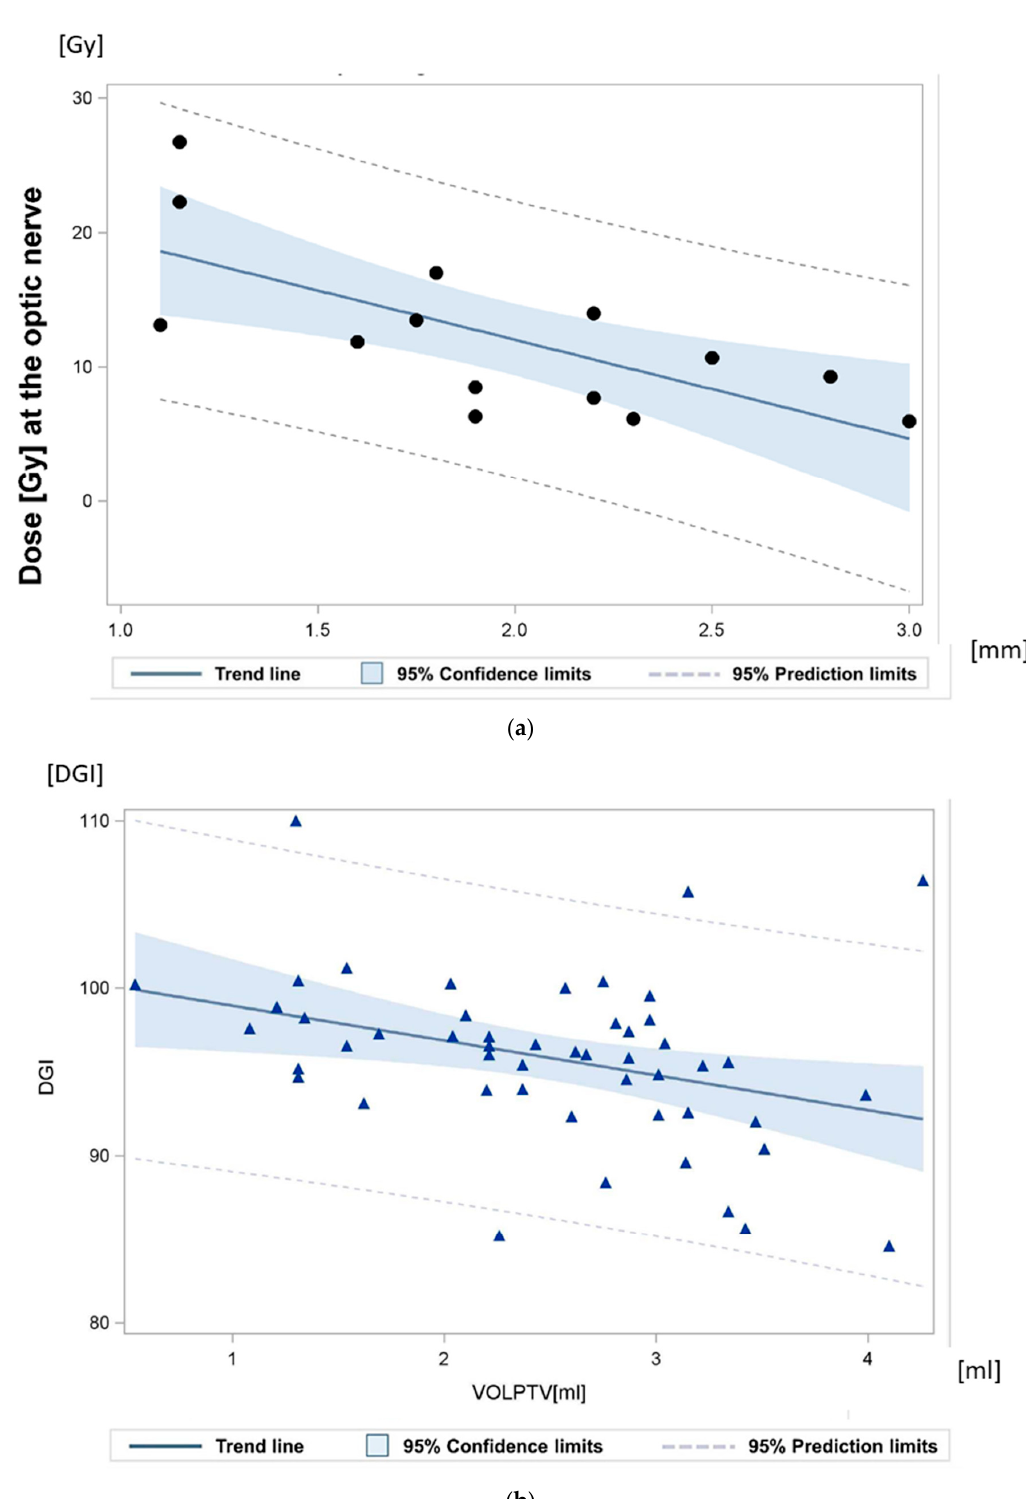
Figure 4. ( a ) Relationship between the maximum dose at the optic nerve, and the minimum distance between the gross tumor and the optic disc. The achieved dose gradient was 7.3 Gy/mm +/ − 2.1 Gy/mm. “ • ” Each sign representing the radiation plan of one patient. ( b ) Dose-gradient index (DGI) quantifying the dose fall-off: the mean dose-gradient index (DGI) for an equivalent sphere equaled 121.20 (120.00–122.64). The calculated DGI for the irregular target volume amounted to 95.86 (84.5–110.01). “ ” Each sign representing one radiation